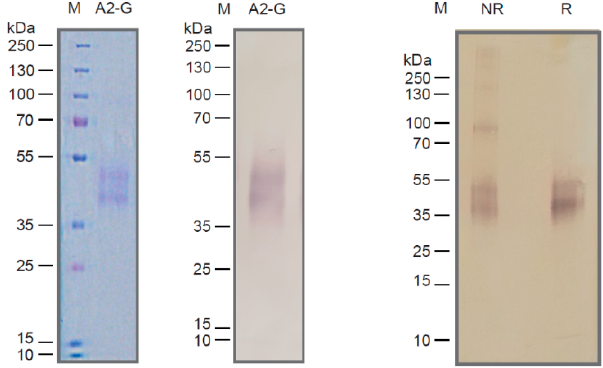
Figure 2. Characterization of recombinant insect cell-expressed G protein. Coomassie-blue stained SDS-PAGE with recombinant A2-G and a molecular-weight marker (kDa: kilo Dalton) (left). Corresponding immunoblot stained with an anti-His-tag antibody (middle). Immunblotted A2-G